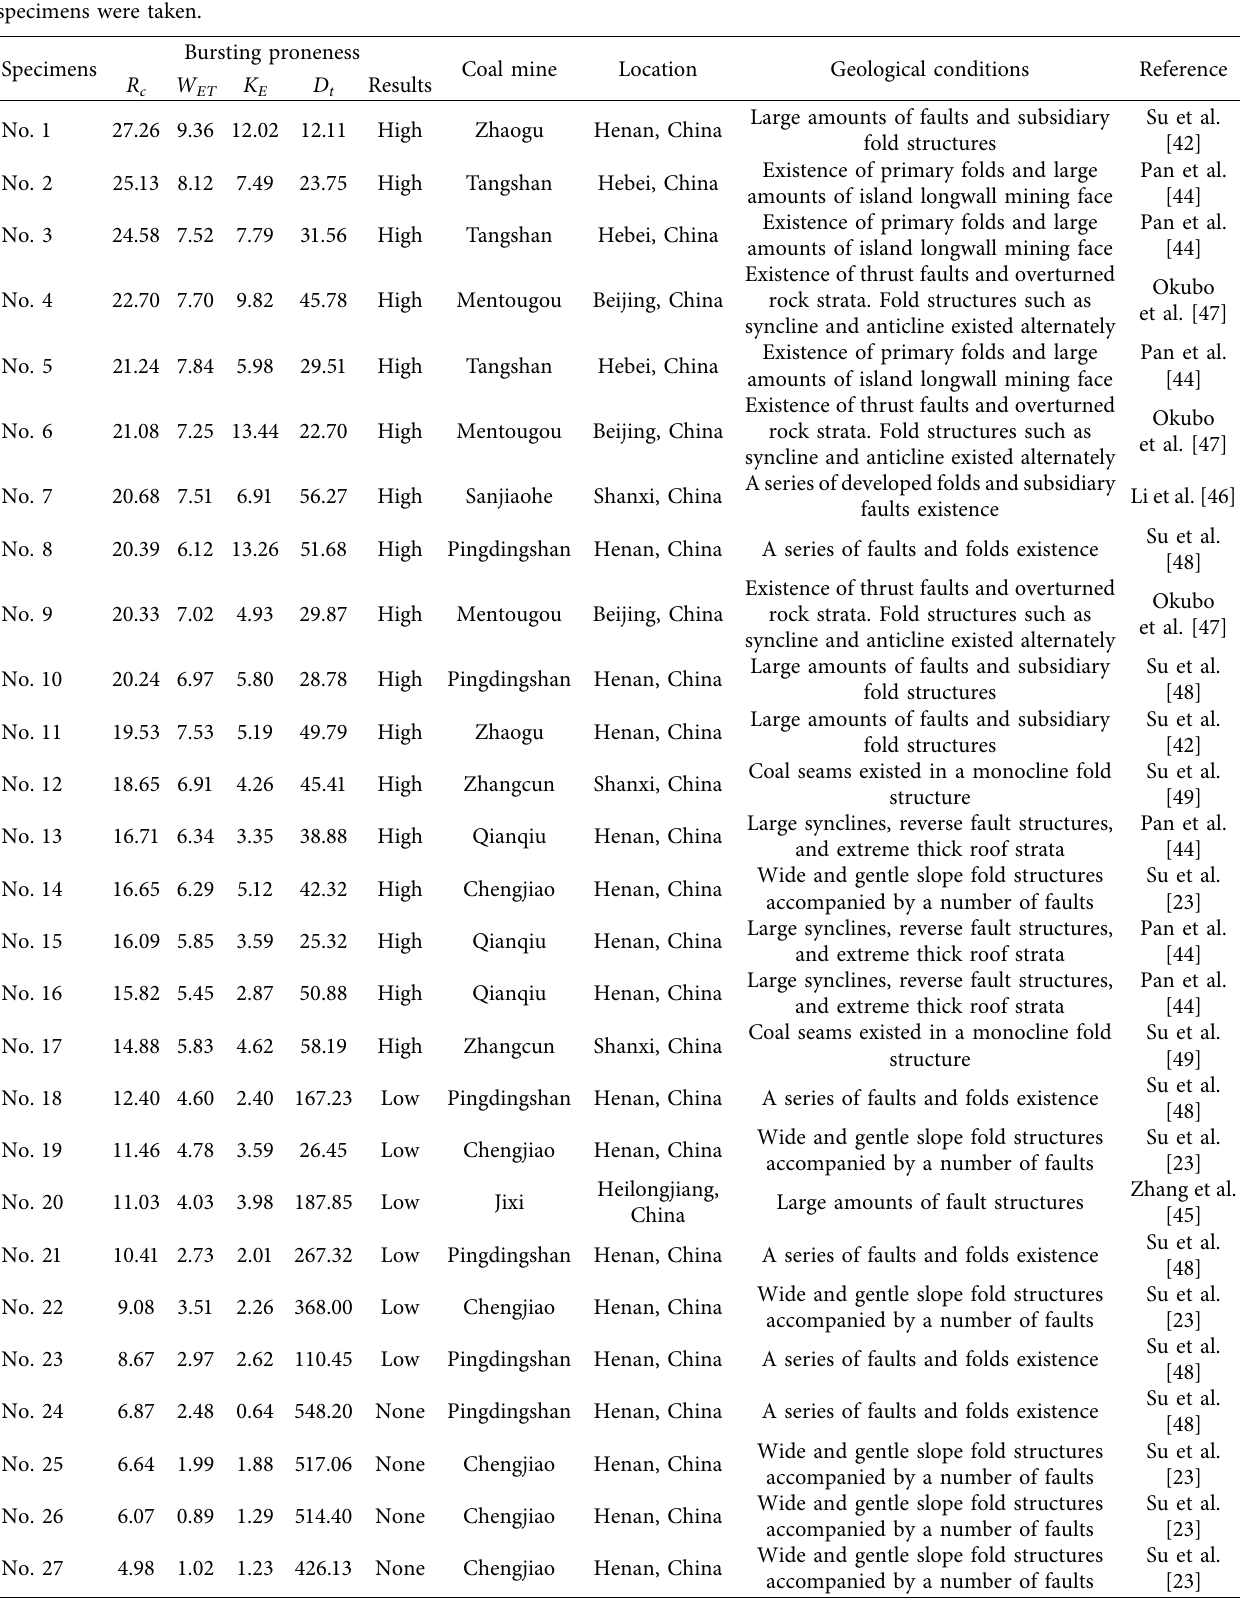
Table 2: Coal specimens and values of bursting proneness indices accompanied by geological conditions of the sites from which the specimens were